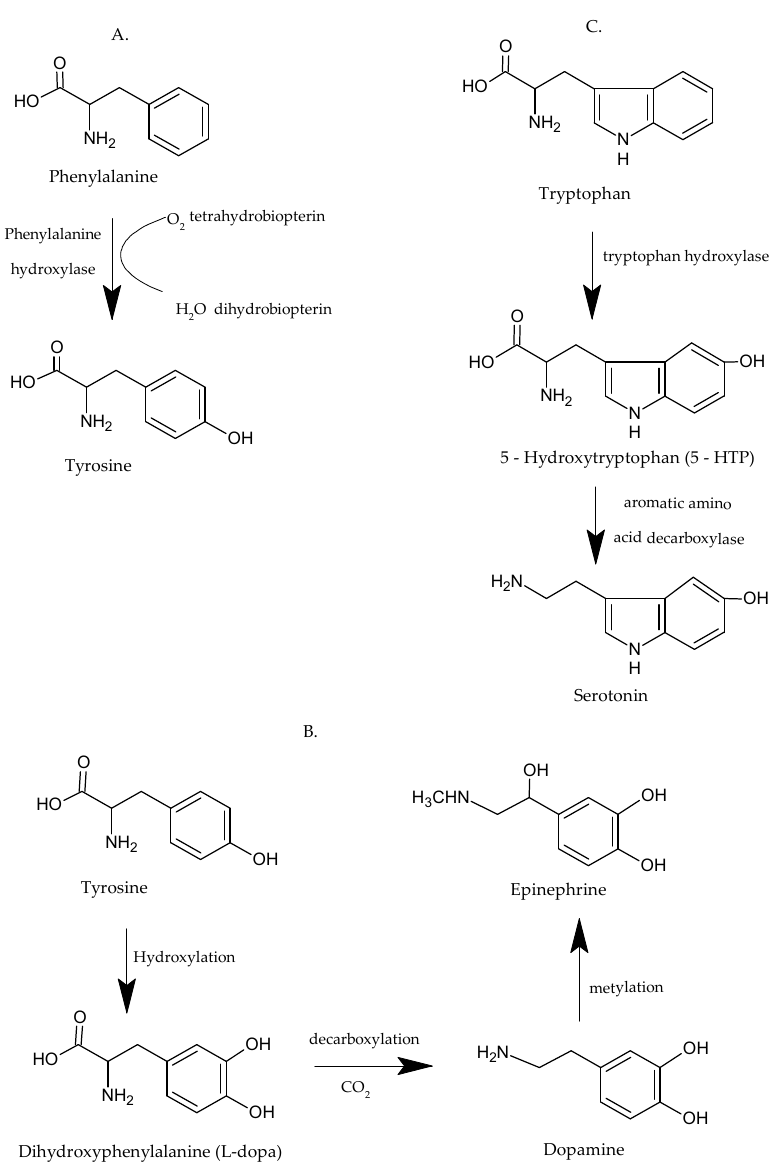
Figure 1. Biosynthesis of amino acids in the human body: ( A ) Phe adapted from [62]; ( B ) Tyr adapted from [67]; and ( C ) Trypt adapted from [68].